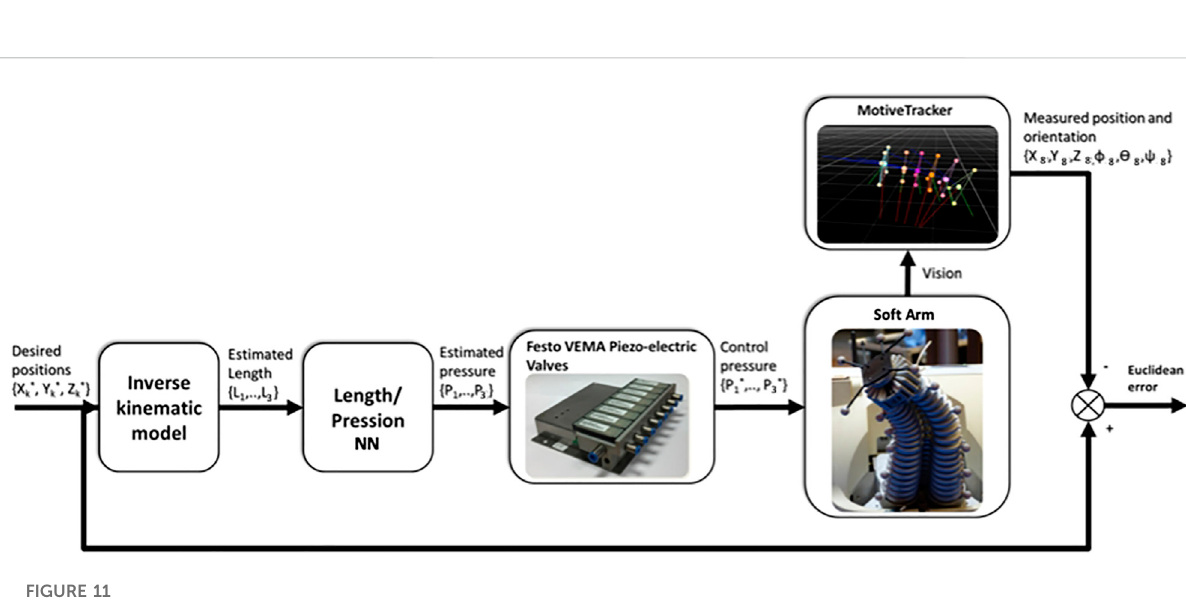
FIGURE 11 Architecture of the inverse kinematic model-based control